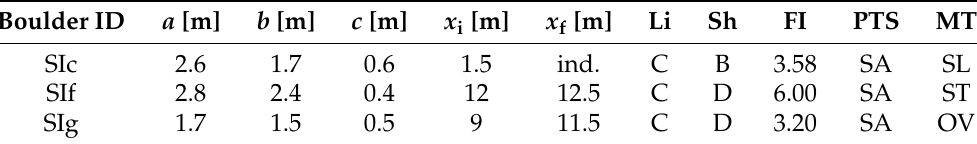
Table A4. Main features of the displaced boulders at the Torre Sant’Isidoro coast; see the caption of Table A2 for symbols.